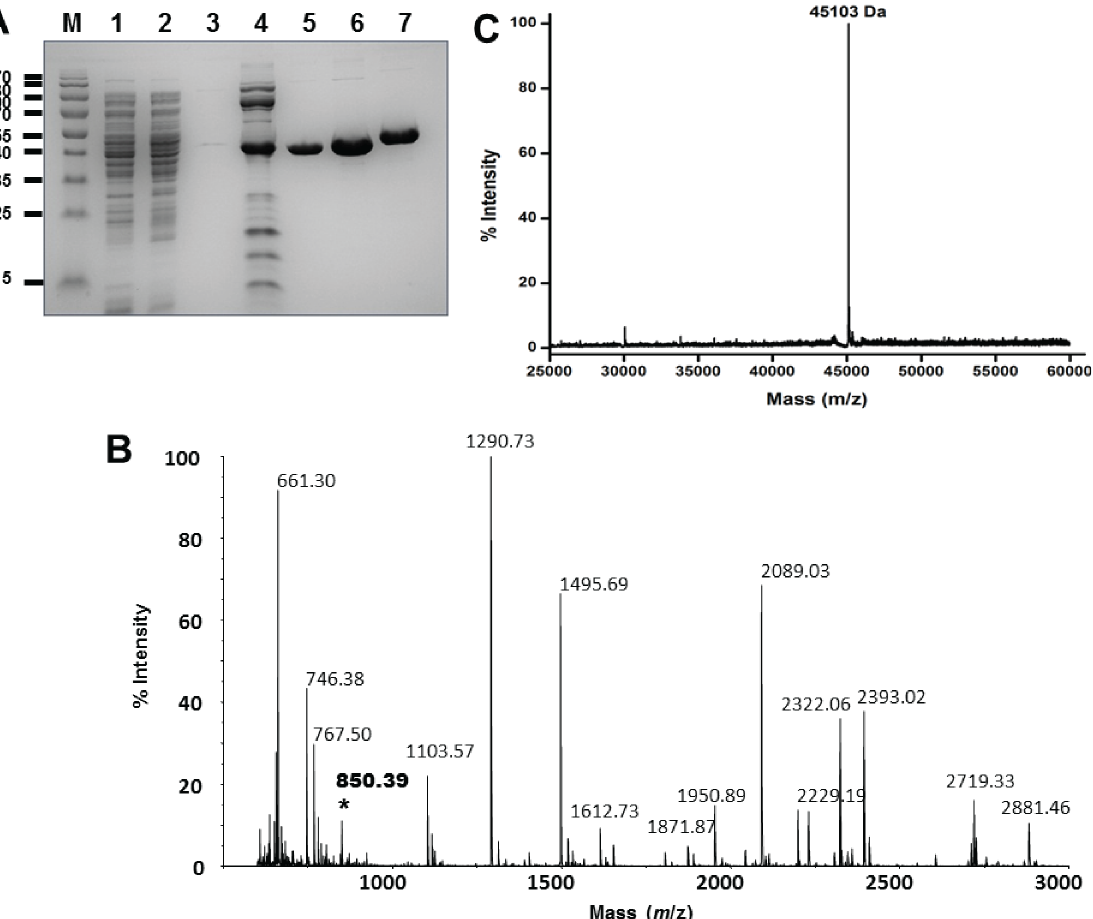
Fig 3. Purification and analytical investigations of the proteins used in study. A , Coomassie blue stained 12% SDS-PAGE analysis of NMT proteins. Lane “ M ” represents protein bands of the applied molecular weight marker and is labeled with the corresponding molecular weight in kDa. A typical expression profile of Δ 28-hNMT1s is shown in lanes 1 – 6 wherein lanes 1 and 2: aliquots of total cell lysate from expression in two representative batches; lanes 3: protein content in wash fraction; lane 3: protein eluted from ion-exchange chromatography; lanes 5 and 6: 5 and 15 μ g protein aliquot after the final purification step on Superdex 75 gel-filtration column. For purity assessments, lane 7 shows 10 μ g protein aliquot of hNMT1s purified in parallel. The purifications yielded proteins with purity > 95%. B , MALDI-TOF mass spectrometry analysis of Δ 28-hNMT1s. The peaks corresponding to deletion at the N- terminal region of hNMT1s were missing and are described in text. The peak of 850.39 Da (marked in boldface with * ) results from the peptide [MEEASKR] at the engineered N-terminus. C , ESI-MS analysis of the Δ 28-hNMT1s with no indications for presence of any degradation or aggregation product. The measured protein mass of 45103 Da exactly matches the calculated